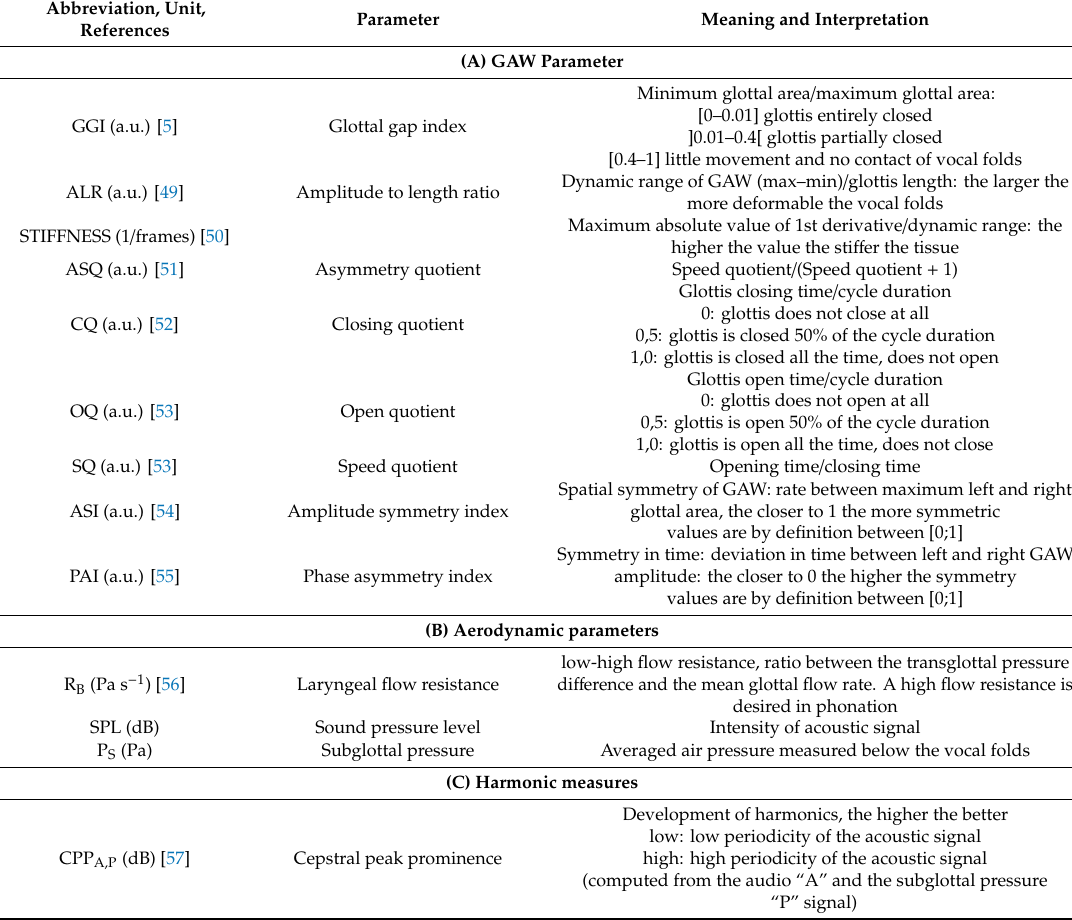
Table 1. Computed parameters with explanations. 1